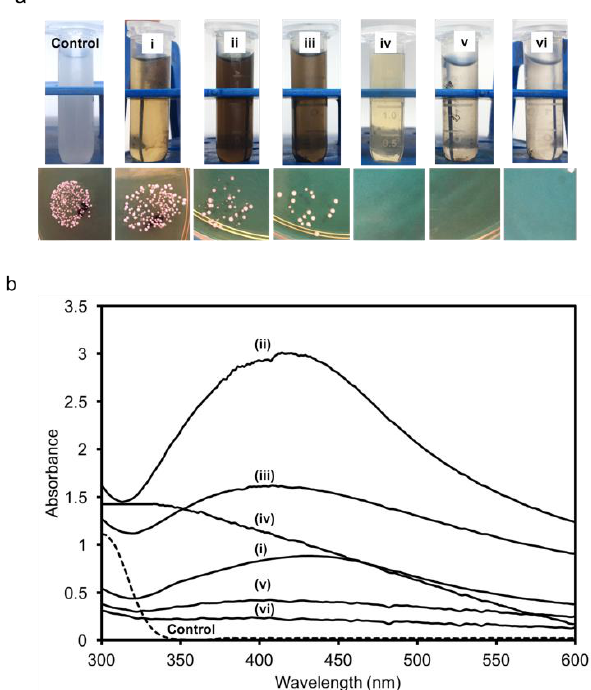
Figure 2. ( a ) Maximum tolerable concentration of L. plantarum TA4 exposed to increasing concentration of Ag + . The bacterial cell growth was determined by the spot platting technique. ( b ) UV – Visible absorption spectra of biosynthesized AgNPs by L. plantarum TA4 exposed with different concentrations of Ag + . (Control) AgNO 3 , (i) 1 mM, (ii) 2 mM, (iii) 4 mM, (iv) 6 mM, (v) 8 mM and (vi) 10 mM.